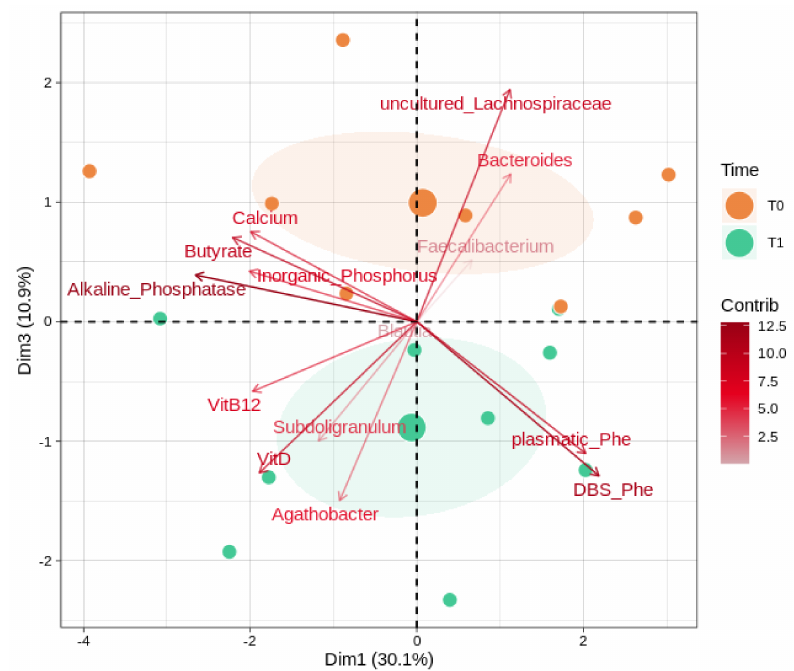
Figure 4. Microbiota, biochemical values, and SCFA interactions. PCA shows correlations